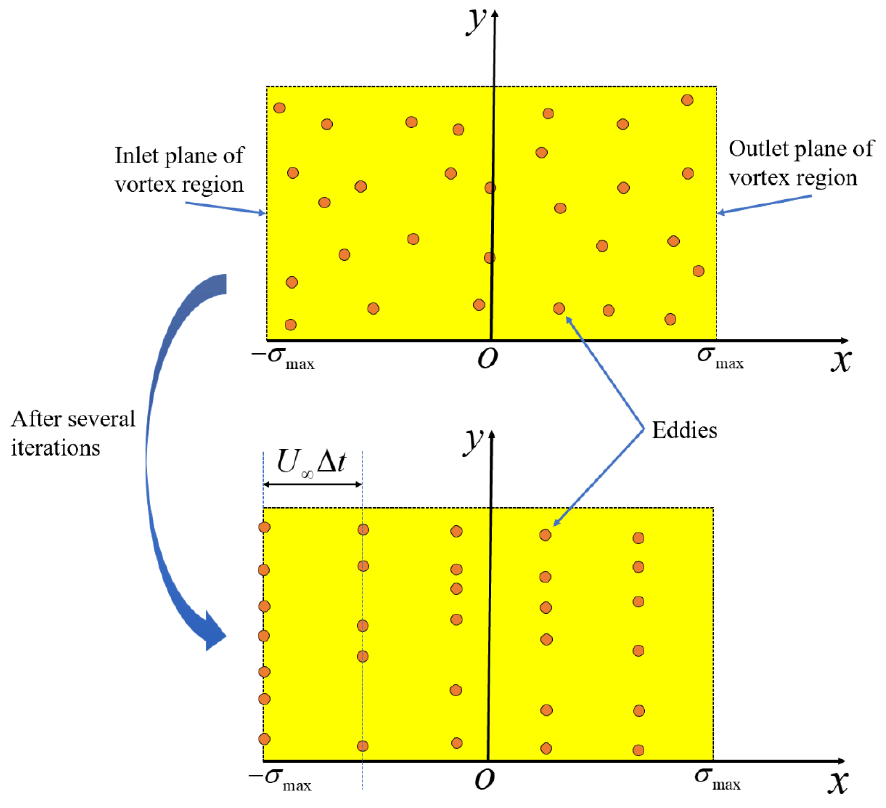
Figure 1. Eddy regeneration in traditional SEM.